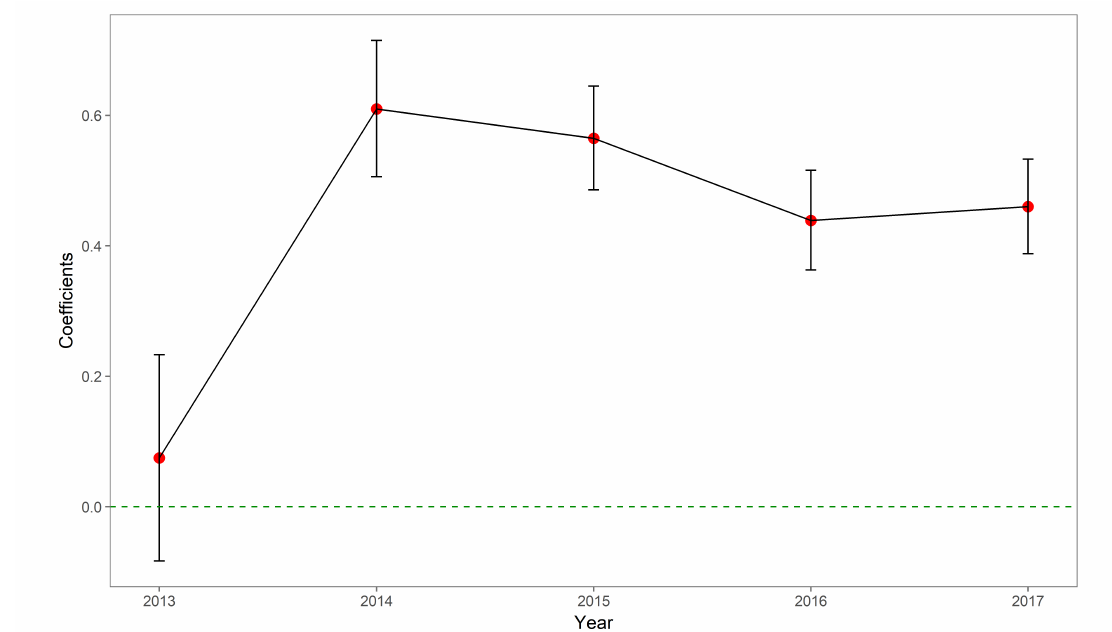
Figure 3. Coefficients of rural patients in terms of non-zero OOP expenses,